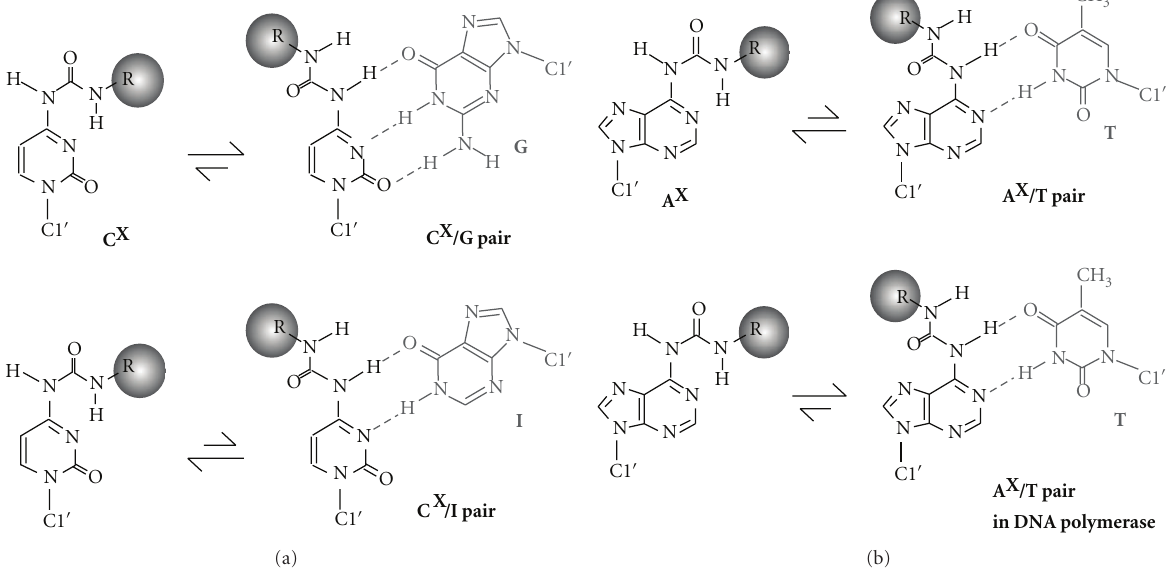
Figure 7: The equilibria between the conformations of the nonpolar group stacking and the base pairing of the deoxycytidine (a) and deoxyadenosine derivatives (b), where R indicates the nonpolar aromatic group of the phenyl or naphthyl